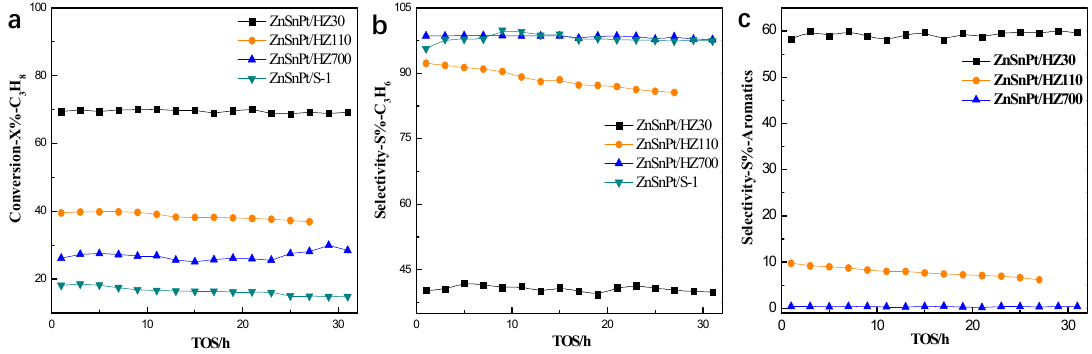
Figure 8. Stability test on ZnSnPt / MFI catalyst with di ff erent SiO 2 / Al 2 O 3 ratios. T = 610 ◦ C, atmospheric pressure, GHSV = 1800 h − 1 . ( a ) The conversion of propane; ( b ) the selectivity of C 3 H 6 ; ( c ) the selectivity of aromatics.